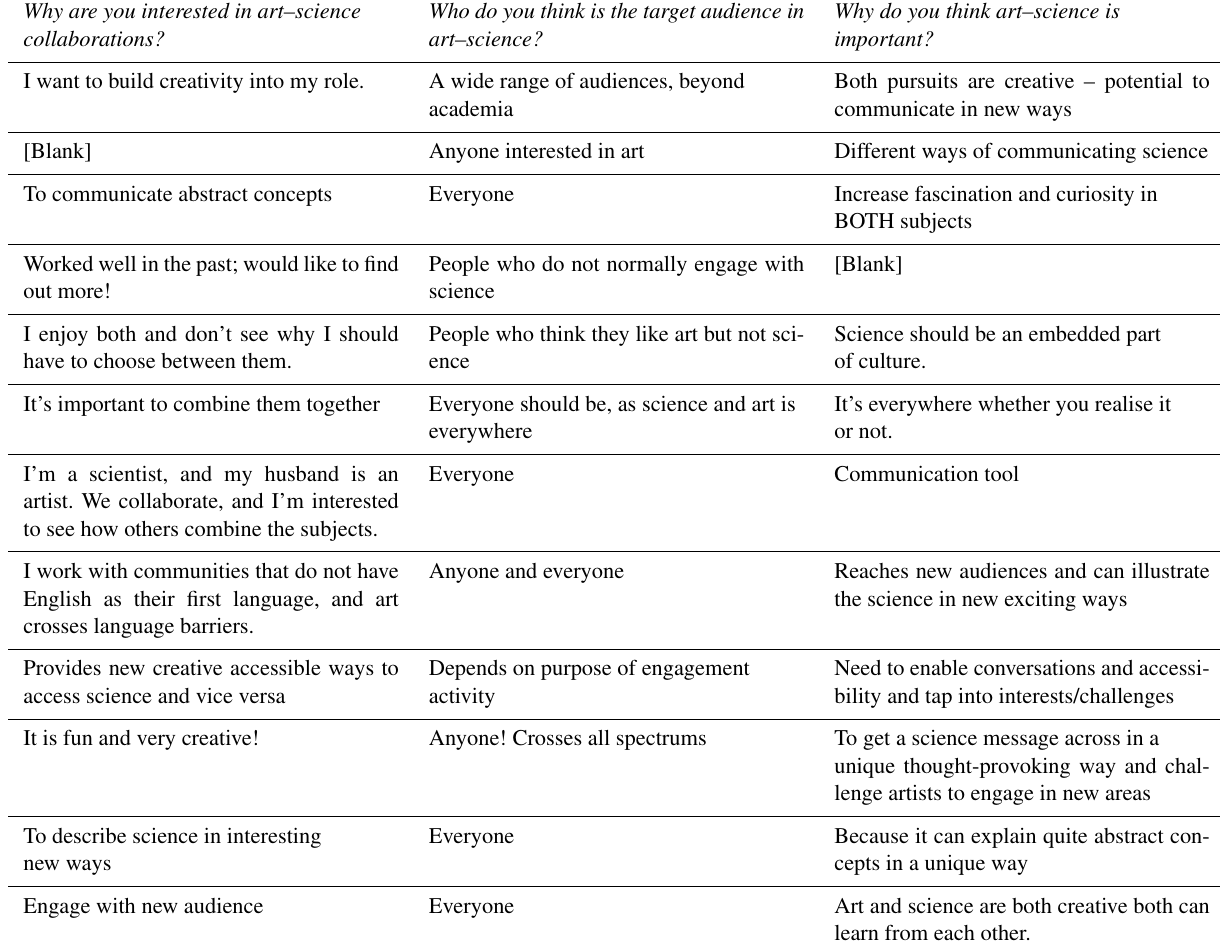
Table B1. Researcher and public-engagement professional thoughts on art–science